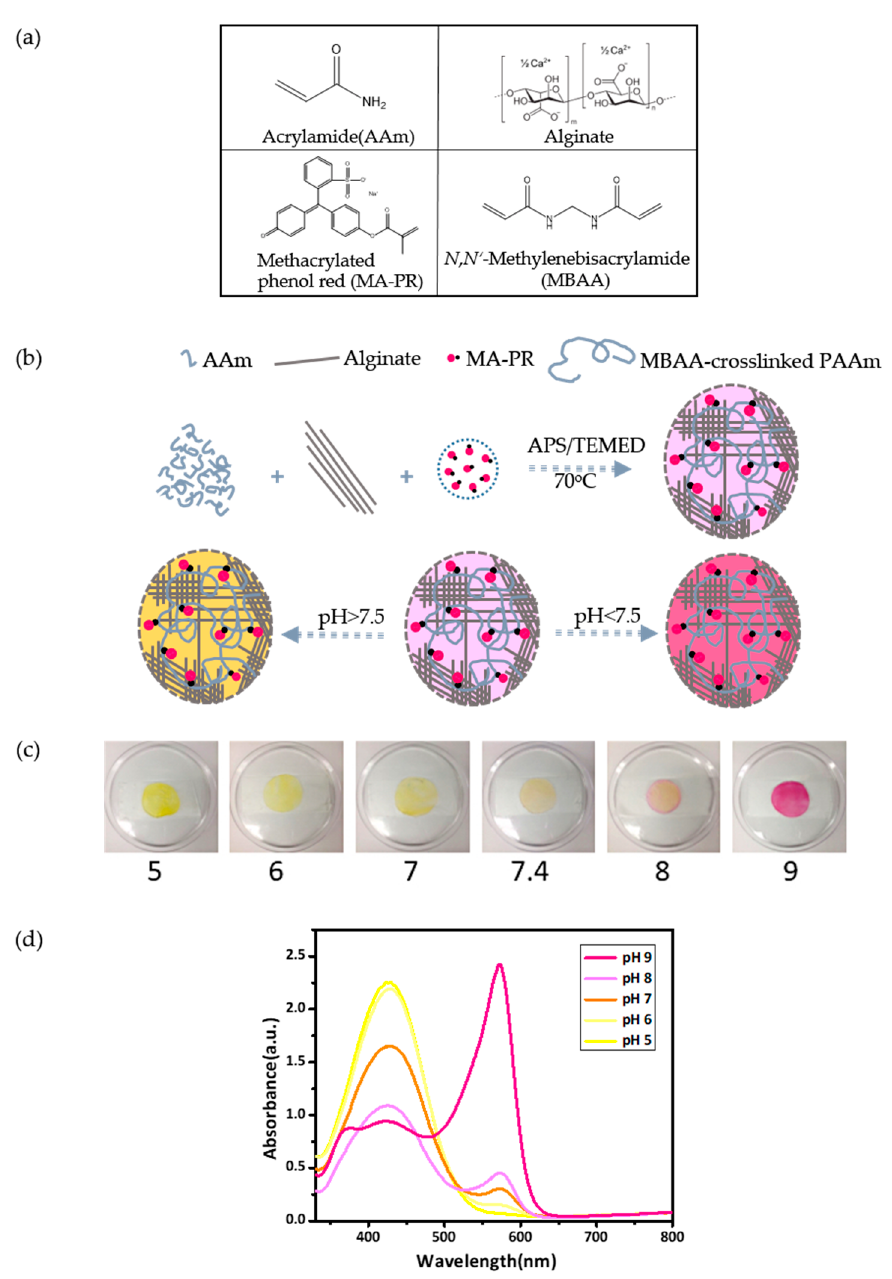
Figure 2. Preparation and characterization of P(AAm-MAPR)/alginate hydrogel patches. ( a ) The chemical structures and the names of the monomers, the dye and the crosslinker used in the synthesis of the alginate/P(AAm-MAPR) hydrogel patch; ( b ) synthetic strategy and colorimetric transitions of the alginate/P(AAm-MAPR) hydrogel patch; and ( c ) photographic images that captured the colorimetric transition of the hydrogel patch in buffer solutions with pH values from 5 to 9 (from left to right). ( d ) UV-VIS absorption spectra of the hydrogel patch while immersed in buffer solutions with pH values from 5 to 9.